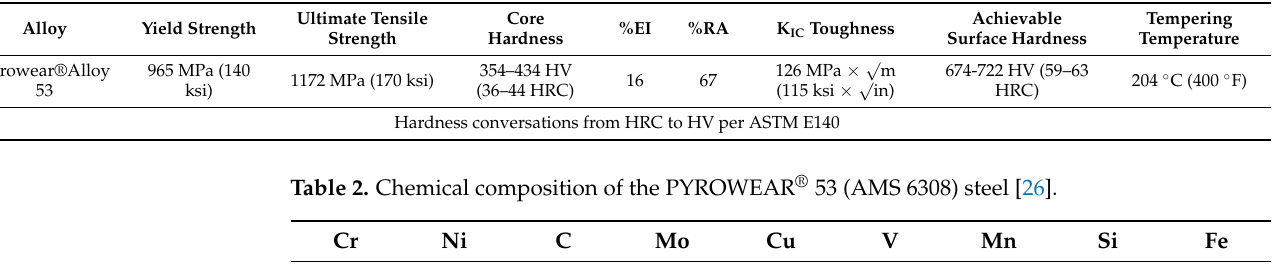
4 of 17 Figure 2. Double helical gear after power skiving machining.